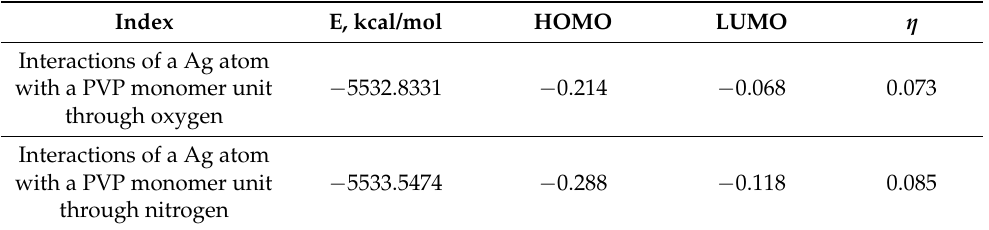
Table 1. Results of quantum chemical calculations of the Ag ‐ PVP molecular system. Index E, kcal/mol HOMO LUMO η Interactions of a Ag atom with a PVP monomer unit through oxygen Interactions of a Ag